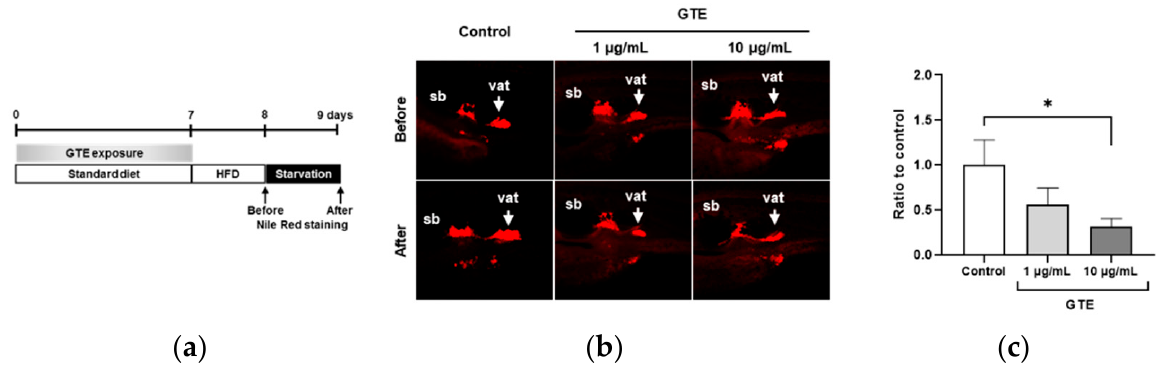
Figure 1. Preventive administration of green tea extract (GTE) suppresses visceral adipose tissue (VAT) accumulation in juvenile zebrafish. ( a ) Scheme of the experimental design. ( b ) Representative images from live zebrafish juveniles after performing two Nile red staining processes shown in ( a ). vat, visceral adipose tissue (VAT); sb, swim bladder; control, HFD-treated control juvenile. ( c ) Quantification of the intensity of the Nile-red-signal-positive area. The y axis shows the ratio of two Nile red staining processes performed compared with the control group. * p < 0.05 vs. control, n = 5. Error bars indicate the standard deviation (SD).